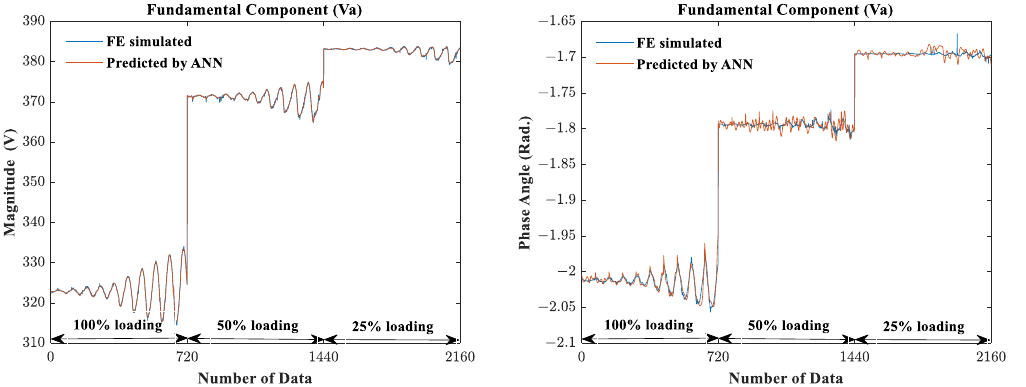
Figure 10. Magnitudes and phase angles of the fundamental harmonic phase voltages simulated by FE and predicted by the developed ANN model.